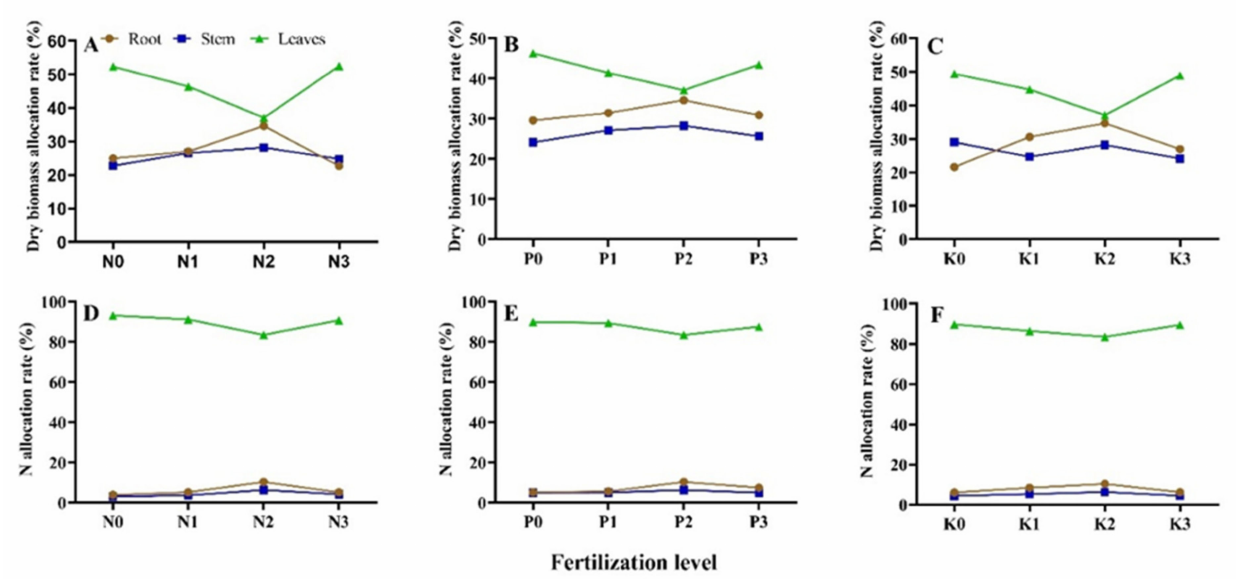
Figure 2. Changes of dry biomass and N allocation rate in P. bournei seedlings under the single-factor of N, P, and K fertilizer. (( A , D ): the single-factor of N fertilizer; ( B , E ): the single-factor of P fertilizer; ( C , F ): the single-factor of K fertilizer). In the X axis label, N, P and K refer to N fertilizer, P fertilizer and K fertilizer, respectively, and numbers 0, 1, 2, and 3, respectively, represent no, low, medium, and high levels of fertilization. Figures 3–7 were the